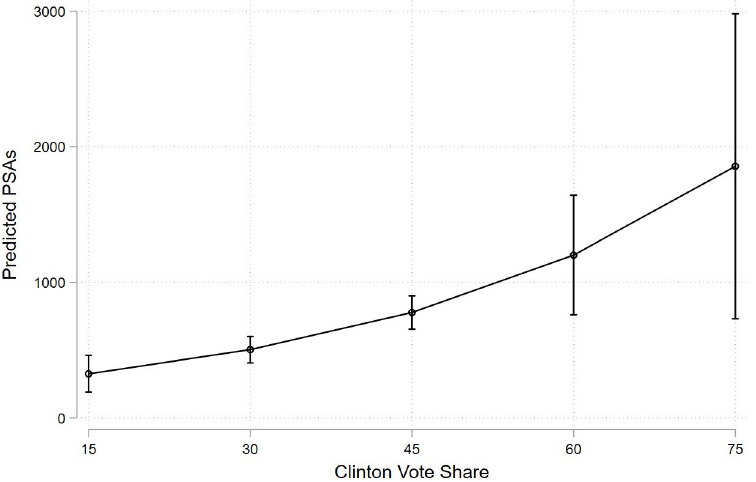
Fig 3. Predicted PSA volume by Clinton vote share. Authors’ analysis of data of PSA airings from Kantar/CMAG merged with data on COVID-19 incidence from the New York Times and market-level demographic data constructed from data from the Atlas of Presidential Elections and the American Community Survey. Figure displays the predicted PSA volume based on the full time period regression model displayed in Table 1, by Clinton vote share, adjusting for all other characteristics listed in Table